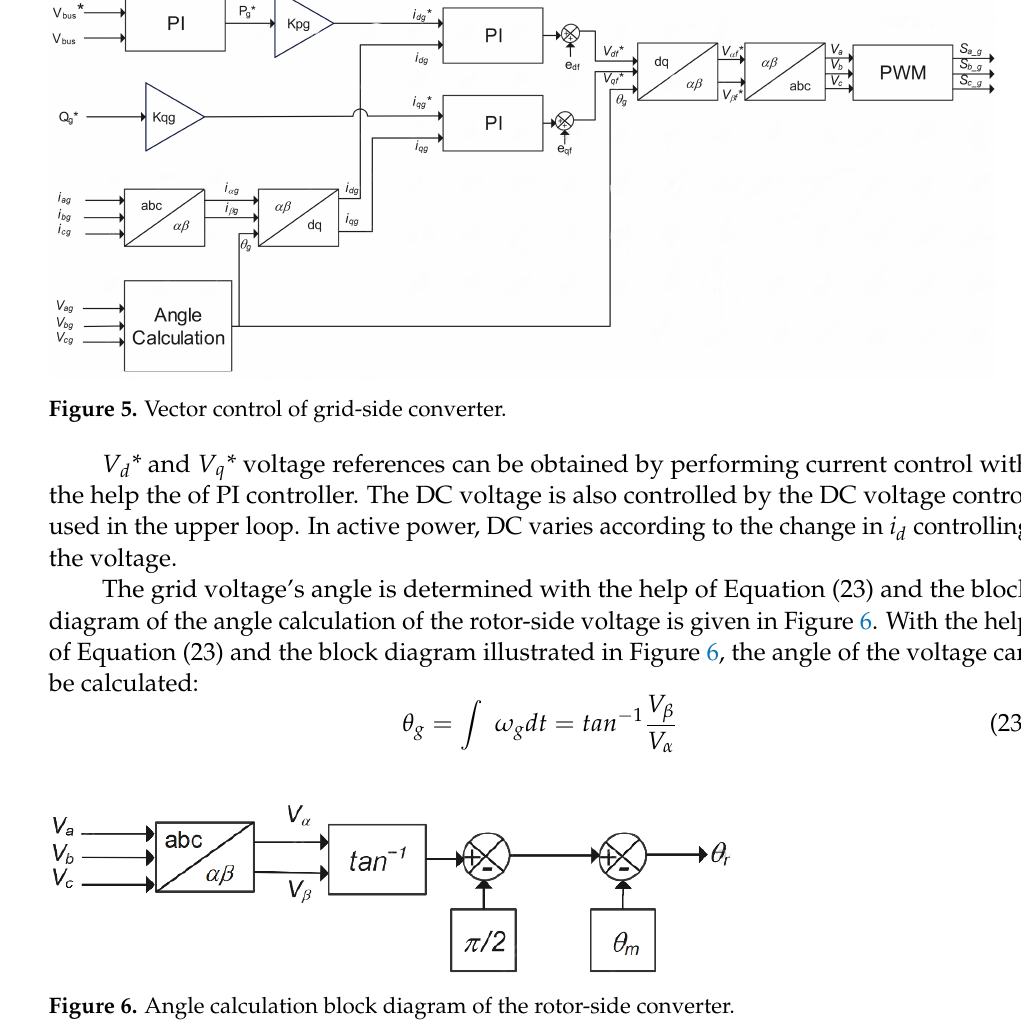
Figure 8. Proposed controller of rotor side converter. The main purpose of adding an MPPT controller to the RSC is to improve the re- sponse time of the WECS, electromagnetic torque, compatibility of the generated power with the power curve, and grid current by producing a more accurate T em * compared with the PI controller. In the MPPT controller, the reference torque value is produced by using the angular velocity and reference angular velocity values of the DFIG. The MPPT con- troller designed in the Matlab/Simulink environment is shown in Figure 9. Figure 9. MPPT controller in Simulink environment. Here, D t_m is the damping constant, N is the gearbox ratio, and K opt is the optimization constant. K opt can be stated as follows: 𝐾 𝑜𝑝𝑡 = 𝜌𝜋 𝑅 5 2λ 𝑜𝑝𝑡3 𝐶 𝑝_𝑚𝑎𝑥 (24) 5. Simulation Setup While analyzing the WECS using Matlab/Simulink, the wind speed data of the Edremit/Balikesir region in Turkey were used as the wind speed profile. The wind energy potential report published by the Ministry of Energy and Natural Resources of the Repub- lic of Turkey in the Edremit/Balikesir region was examined. According to the report, it was observed that the transmission voltage is 154 kV in this region and the most compat- ible generator model for the region is the Nordex N90/2.5 MW. The WECS was designed according to setup criteria such as using real wind profile and using real parameters of the turbine model to obtain realistic and applicable results obtained from the system de- signed in Matlab/Simulink. Parameters of the DFIG designed in MATLAB/Simulink are